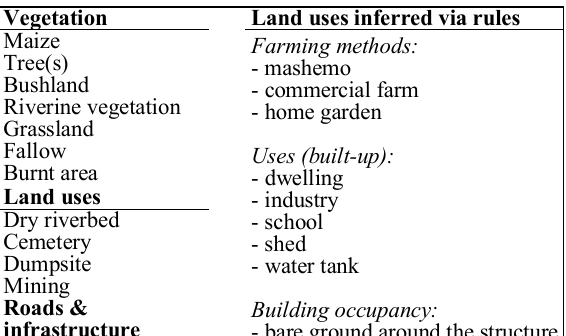
Farming methods: - mashemo - commercial farm - home garden Uses (built-up): - dwelling - industry - school - shed - water tank Building occupancy: - bare ground around the structure vs. overgrown with grass RDP houses: - based on roof size and shape Wealth of household (indicators): - slate/tile roof - fruit trees - greenness of lawn - water tank(s) Kraal: - black soil colour and closeness to house Wild natural resource use: - based on footpaths Former woodlands: - based on termite mounts